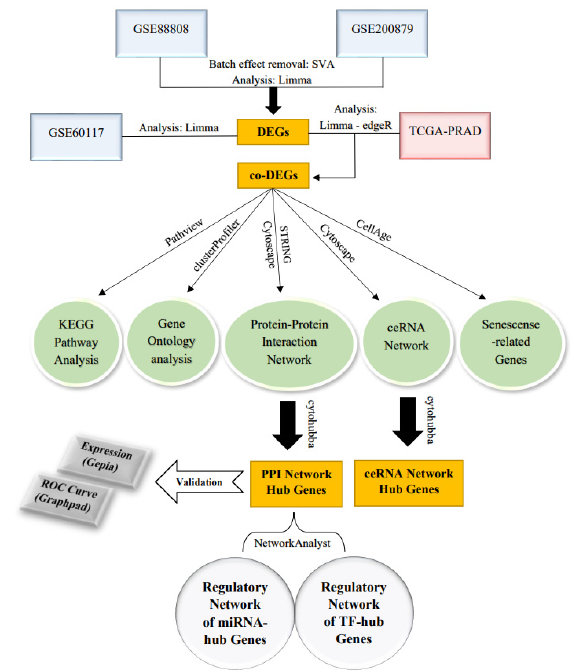
Figure 1. The workflow of the study.